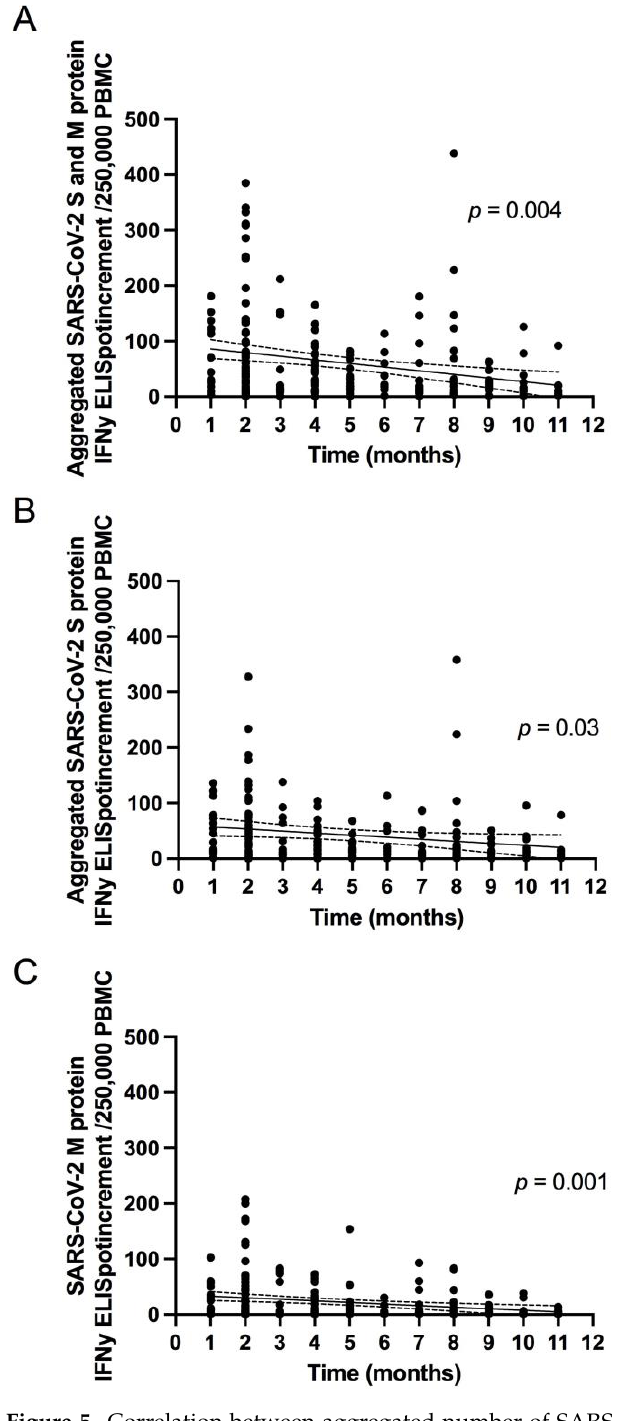
Figure 5. Correlation between aggregated number of SARS-CoV-2 Spike (S) and Membrane (M) protein specific T cell responses (( A ); p = 0.004, R = − 0.2), aggregated number of S protein specific T cell responses (( B ); p = 0.03, R = − 0.1) and M protein specific T cell responses (( C ); p = 0.001, R = − 0.2) and the time since initial COVID-19. Regression line (black line) with 95% confidence interval (dashed lines).